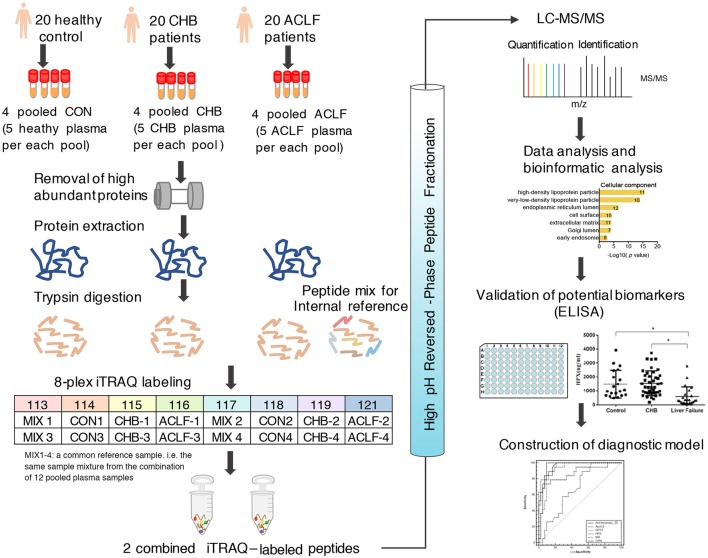
Workflow chart of the proteomic study. Twelve pooled plasma samples (pooled from n = 5) from 20 healthy controls, 20 CHB patients and 20 ACLF patients were subjected to removal of high abundant proteins. Then equal amounts of proteins from each sample were digested with trypsin. Resultant peptides were processed 8-plex iTRAQ labeling, HPRP fractionation and subsequent LC-MS/MS analysis. Bioinformatics analysis was performed using Uniprot and STRING database. The plasma levels of candidate proteins were further verified by ELISA assay and diagnostic value of these biomarkers were assessed by forward stepwise logistic regression analysis and ROC curve analysis.